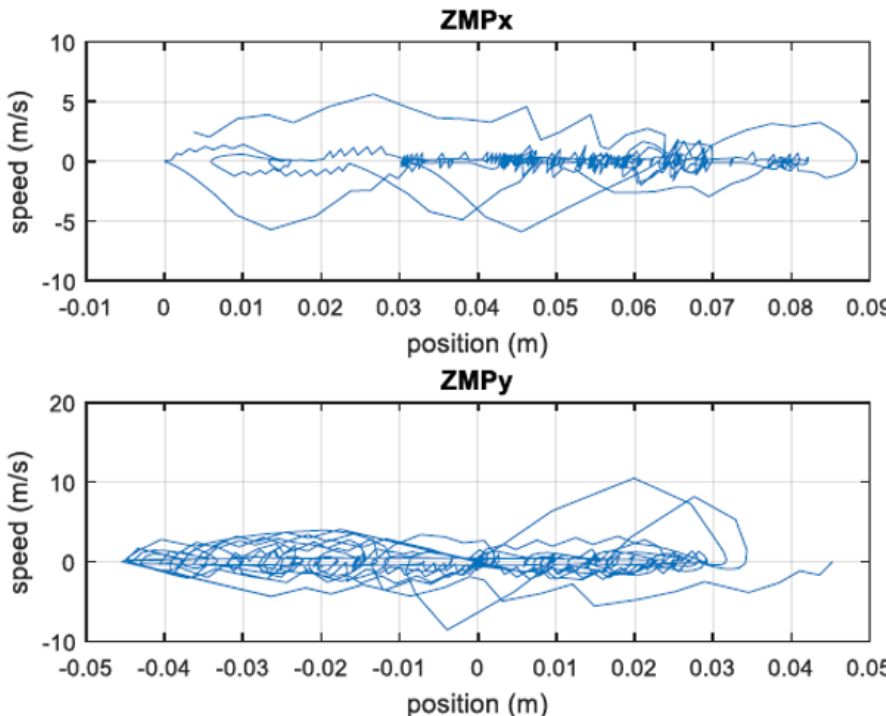
Figure 10. The ZMP hodograph of the NAO robot presented in the phase-plane in the sagittal and lateral direction of motion